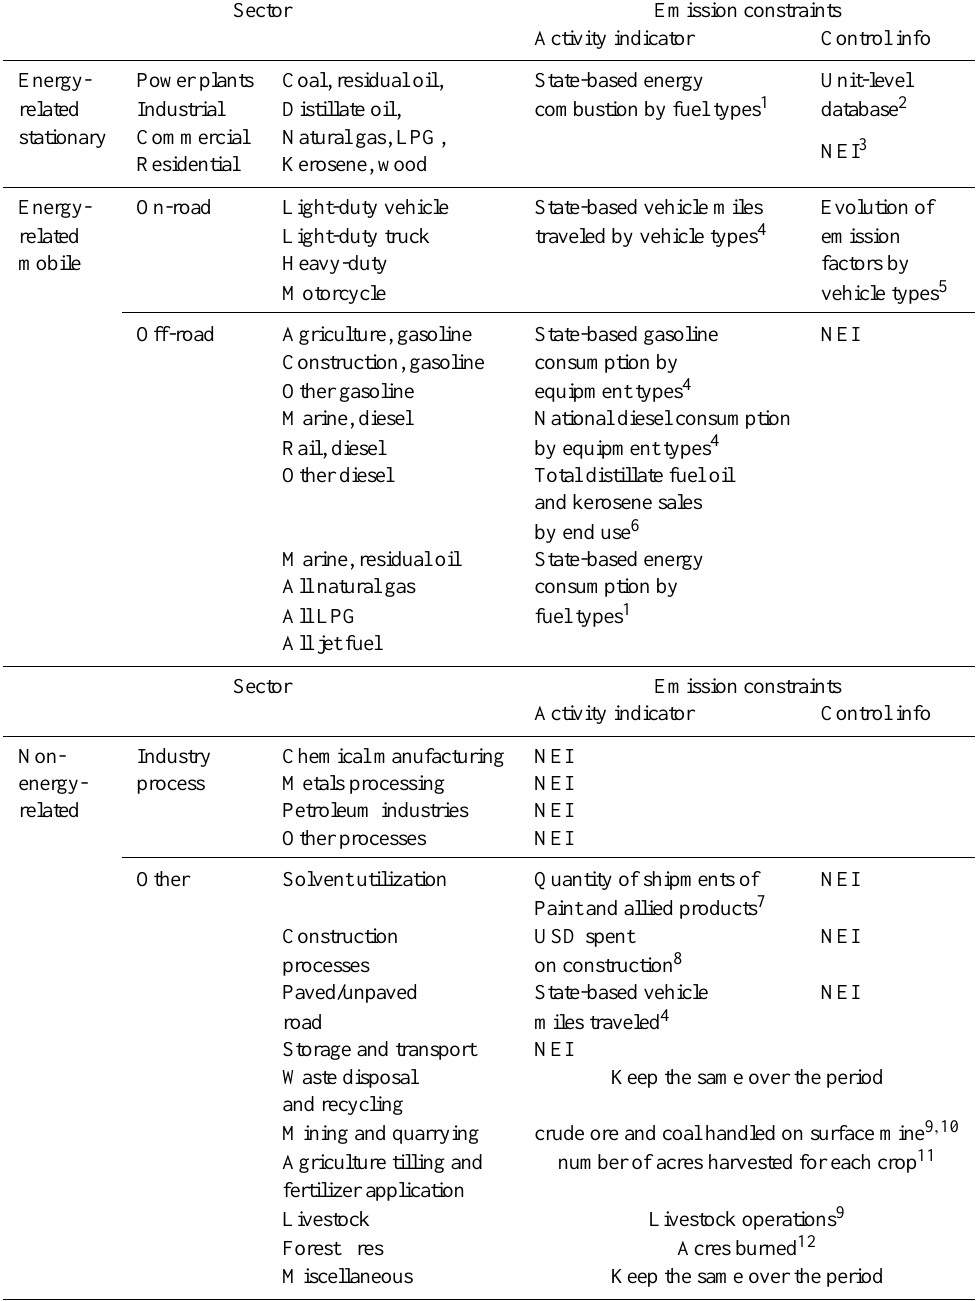
Table 2. Summary of data sources used for scaling